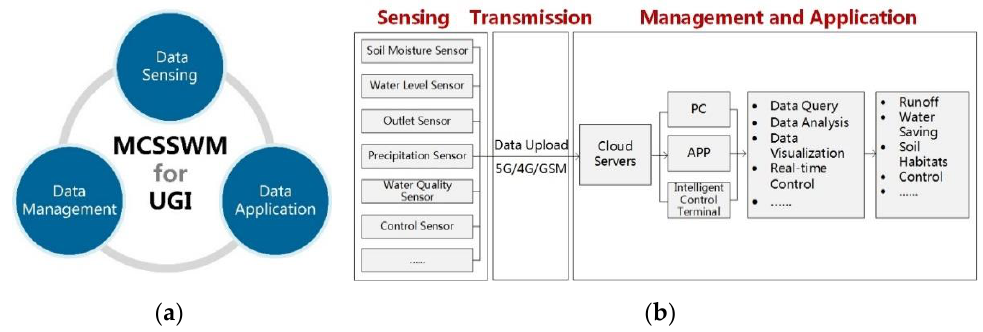
Figure 1. The framework of MCSSWM for UGI ( a ) and a roadmap of its application ( b ).